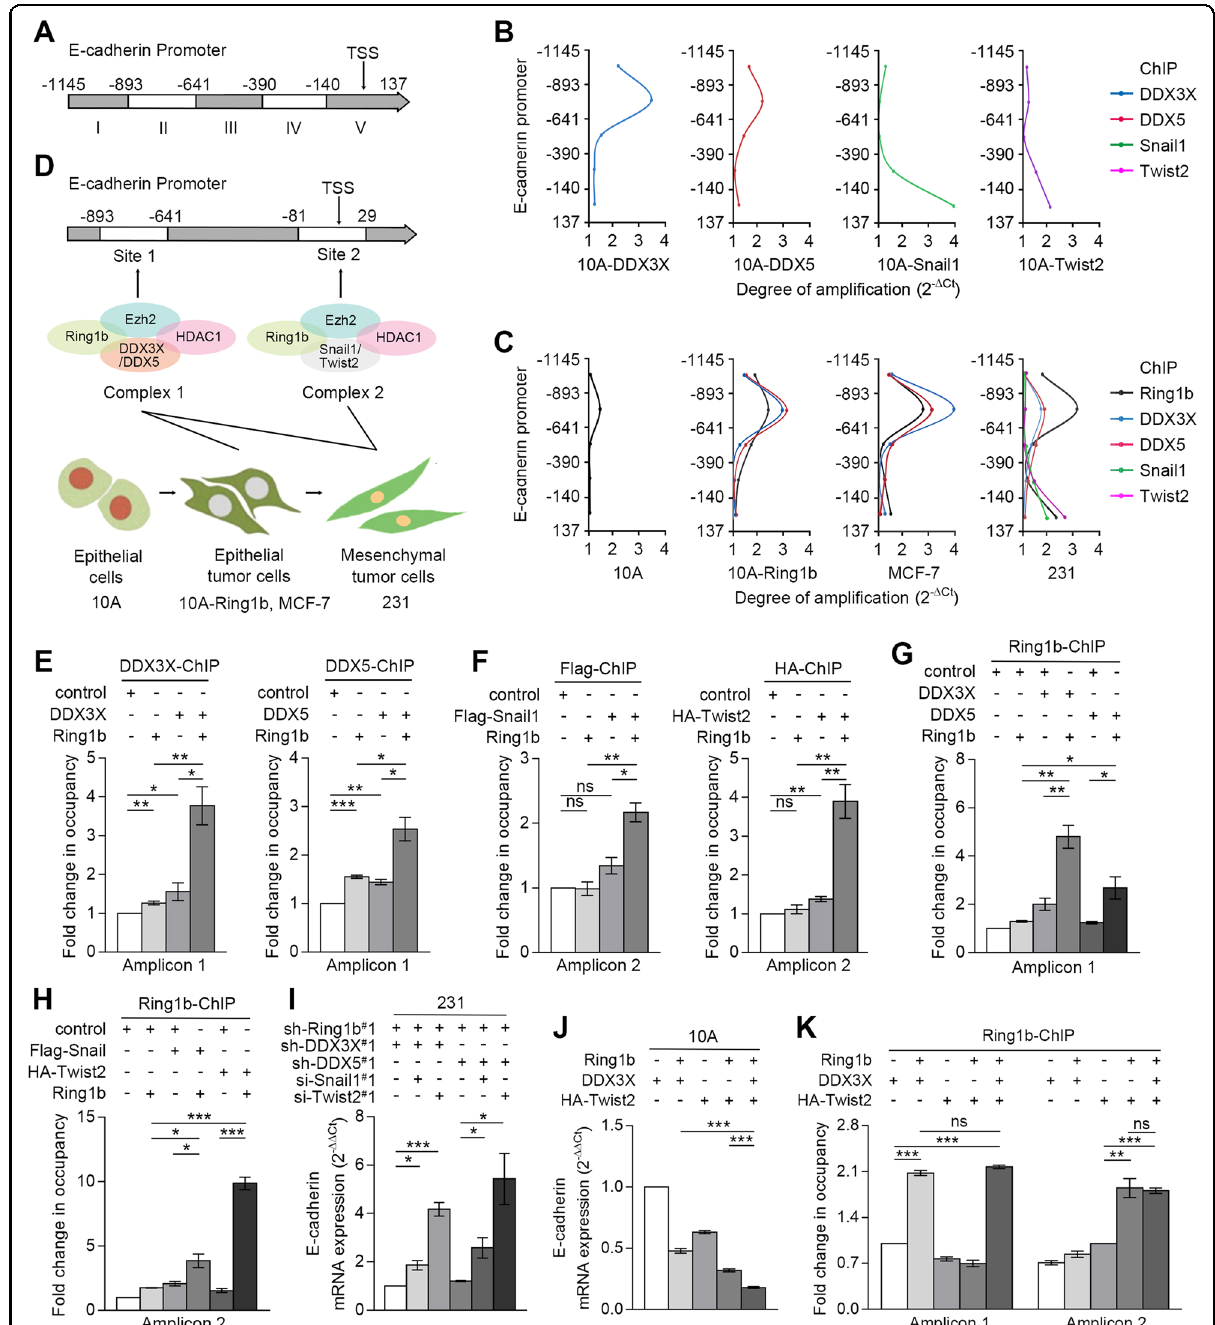
Fig. 5 Ring1b complexes inhibit E-cadherin expression at transcriptional level. Proteins as indicated were stably overexpressed or knocked down in cells using lentivirus or si-RNA. IgG was used as control antibody. The probability of proteins binding to the E-cadherin promoter was analyzed by ChIP-qRT-PCR. A Schematic representation of E-cadherin promoter region. E-cadherin promoter was divided into fi ve regions to determine the degree of ampli fi cation. B, C DNA binding ability of DDXs, EMT TFs, and Ring1b on the E-cadherin promoter. Immunoprecipitated DNA fragments were captured by antibodies speci fi c to DDX3X, DDX5, Flag (Snail1), HA (Twist2), and Ring1b in breast cell lines. D Schematic diagram of Ring1b complexes associated with metastatic features in breast cells. E – H Effect of Ring1b complexes on E-cadherin transcription. Immunoprecipitated DNA fragments from 10 A cells were captured by antibodies speci fi c to Ring1b, DDX3X, DDX5, Flag (Snail1), and HA (Twist2). I, J Effect of three proteins on E-cadherin expression. Total RNAs isolated from 231 and 10 A cells were analyzed by qRT-PCR. K Recruitment of Ring1b at site 1 and 2 in 10 A cells. Immunoprecipitated DNA fragments from 10 A cells were captured by antibody speci fi c to Ring1b. Error bars represent the means ± SEM. Unpaired t -test is performed to indicate a statistically signi fi cant difference. ns, P ≥ 0.05; * P < 0.05; ** P < 0.01; *** P <